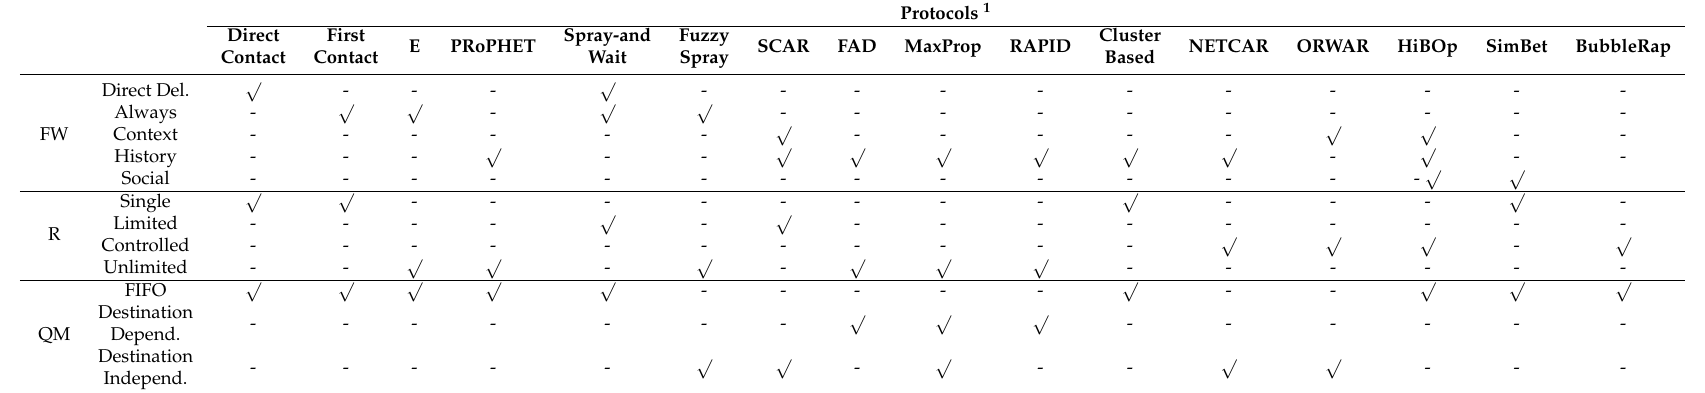
Table 1. Protocol classification. QM, queue management; FIFO,